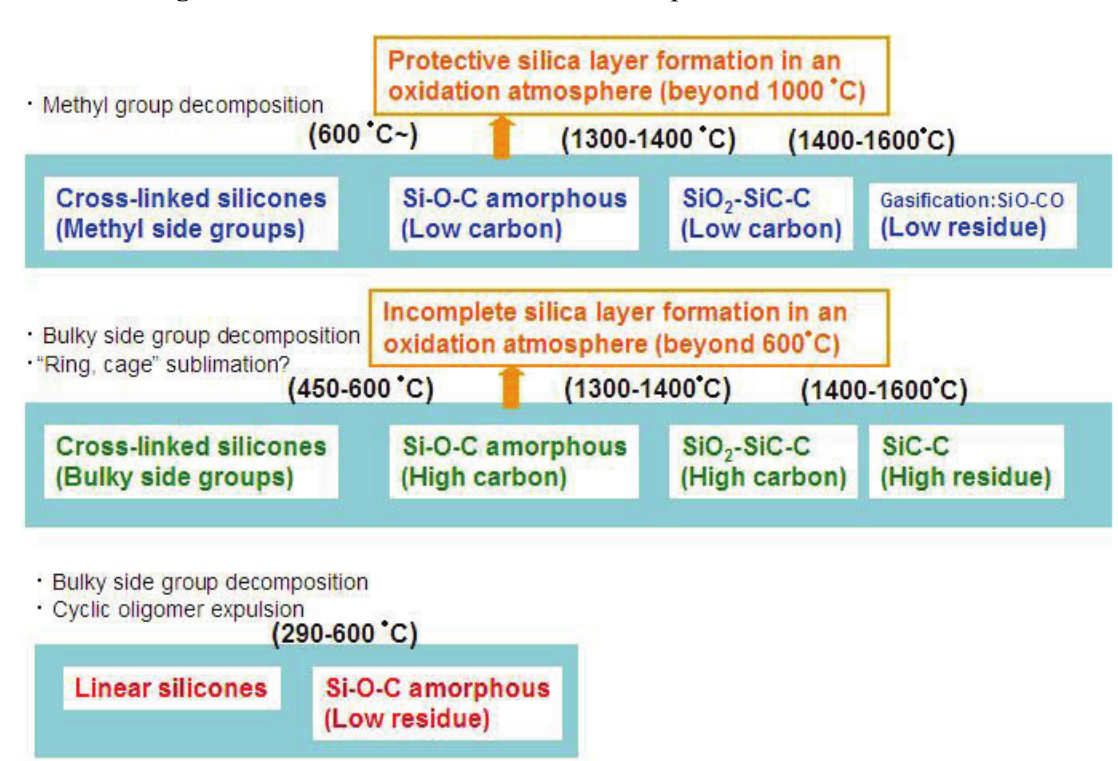
Figure 2. Various modes of thermal decomposition of silicone